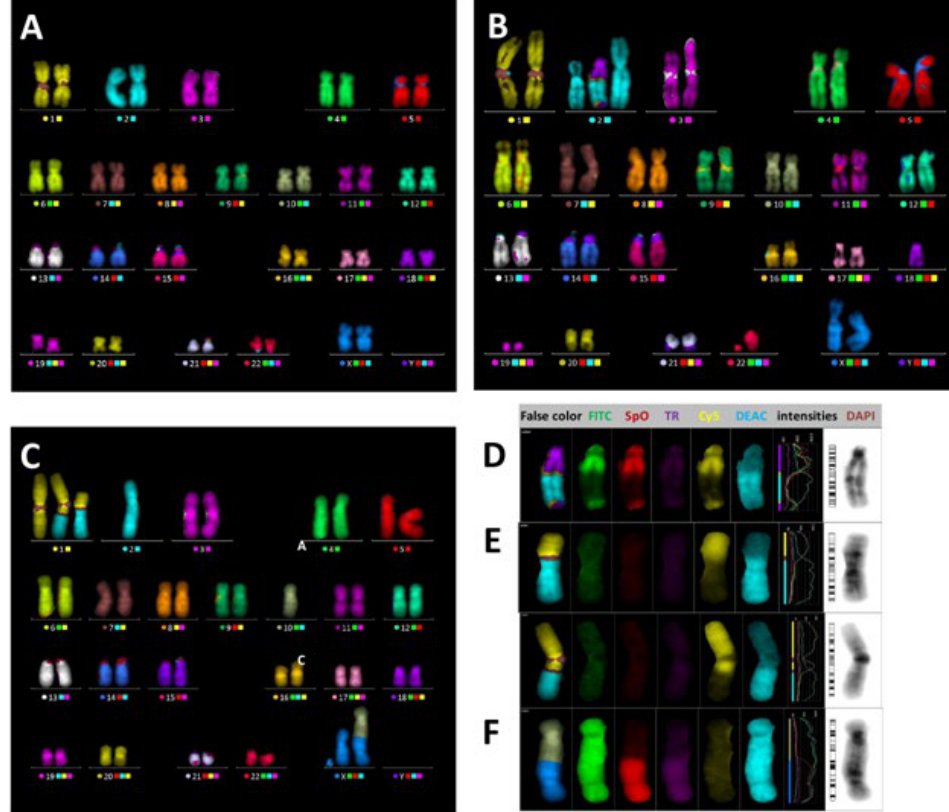
Figure 4. Patient 1, day 4. ( A ) Normal human female karyogram obtained by the mFISH method. Each chromosome pair is identified by software on the basis of a unique combination of fluorescent dyes (the squares to the right from the chromosome number) and is presented in pseudo colors generated by ISIS/mFISH software for analysis convenience. ( B ) Complex aberration tr 18 ′ -2-18 + T 2′ described by the ratio C/A/B 2/2/3. ( D ) Insertion tr 1 8′ -2-18. Single color gallery provides full information about painted items (from left to the right): pseudo colors, five fluorochromes, intensity profiles of all fluorochromes, and DAPI image. Patient 2, day 2323. ( C ) Two simple exchanges were observed: reciprocal translocation tr 1′ -2 + tr 2′ -1—stable aberration ( E ) dicentric 1 0′ -X’ + ace 10-X—unstable aberration ( F ). The cell containing at least one unstable aberration is regarded as unstable.